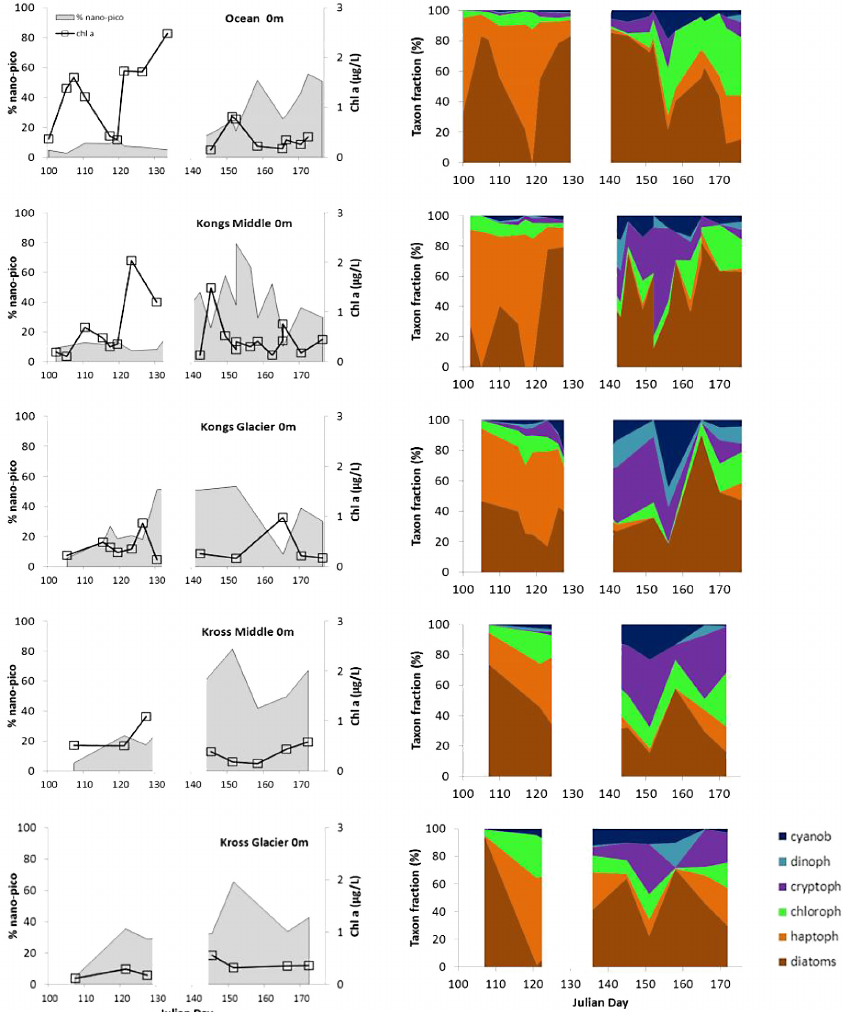
Fig. 5. Surface samples pigment data of all stations over time (Julian days). Left panel shows surface biomass (black line) and the relative contribution of nano–picoplankton to the total Chl a (grey surface). Right panel shows the relative pigment class composition (cyanophytes, dinoflagellates, cryptophytes, chlorophytes, haptophytes and diatoms) to the total Chl a